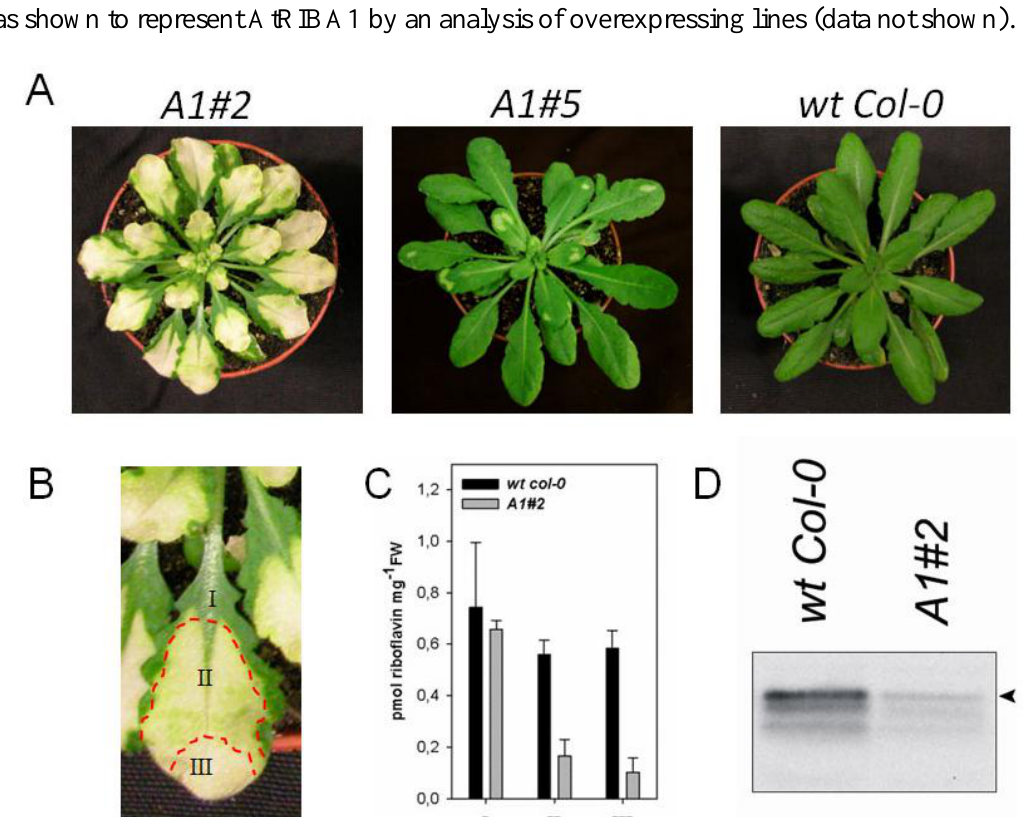
Figure 3. Phenotype of antisense AtRIBA1 plants. ( A ) Different degrees of bleaching are the result of AtRIBA1 antisense expression. Plants displaying a moderate antisense phenotype (left panel) start to bleach partially at the tip of leaves in the rosette stage, while individuals with a stronger reduction in AtRIBA1 transcript amounts display white inner rosette leaves and shoot apical meristem (middle). A Arabidopsis thaliana